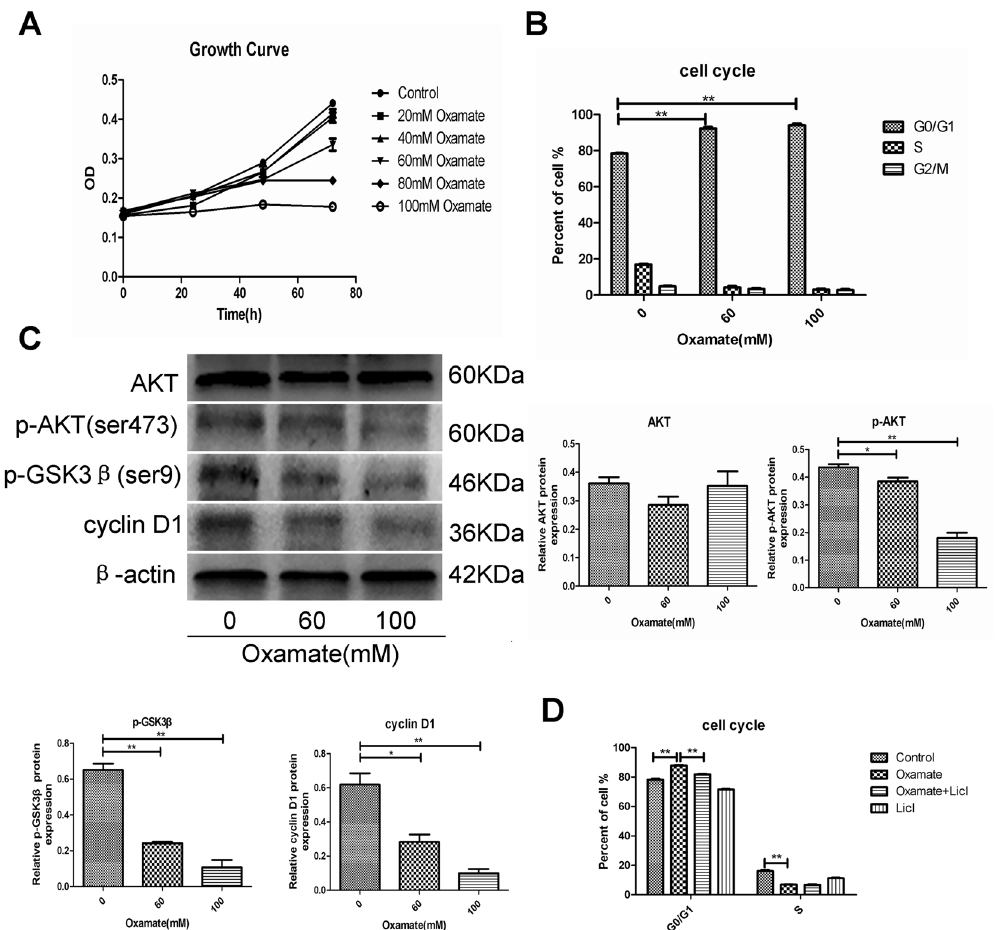
Figure 5. Akt-GSK-3 β -cyclinD1 signal pathway mediates Cell cycle arrested by oxamate in GH3 cells. ( A ) GH3 cells were incubated with different concentrations of oxamate for 0, 24, 48 and 72 h, and cell proliferation were tested by CCK-8 assay (n = 3, ± SEM). ( B ) GH3 cells were exposed to 0, 60, and 100 mM oxamate for 48 h, and then cell cycle were analyzed using flow cytometry (n = 3, ± SEM). ( C ) GH3 cells were exposed to 0, 60, and 100 mM oxamate for 48 h, and protein expression levels of Akt, p-Akt, p-GSK3 β and CyclinD1 were examined by Western blot (n = 3, ± SEM). ( D ) GH3 cells were pretreated with or without Licl and then treated with oxamate. Cell cycle were analyzed using flow cytometry (n = 3, ± SEM). * P < 0.05; ** P <